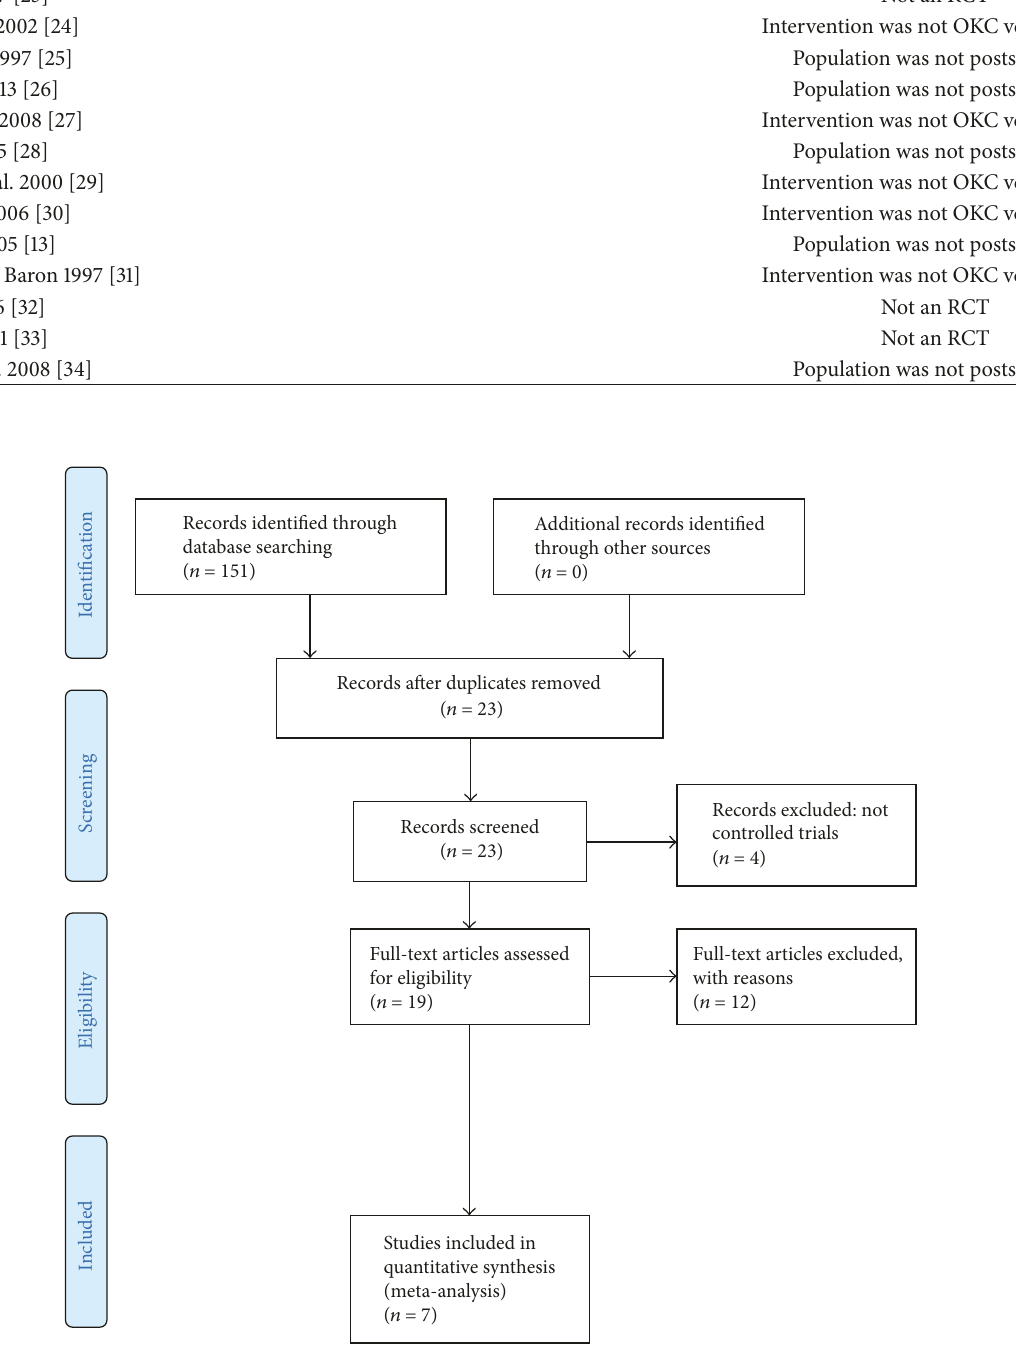
Figure 1: CONSORT